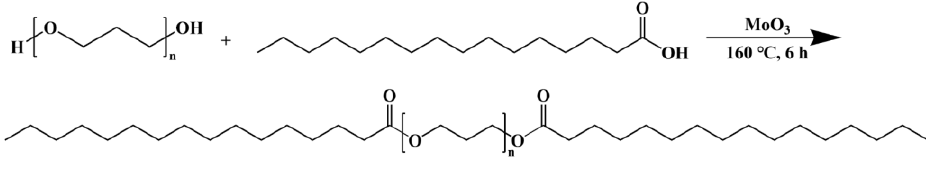
Figure 1. Synthesis route of PO3G–PA.